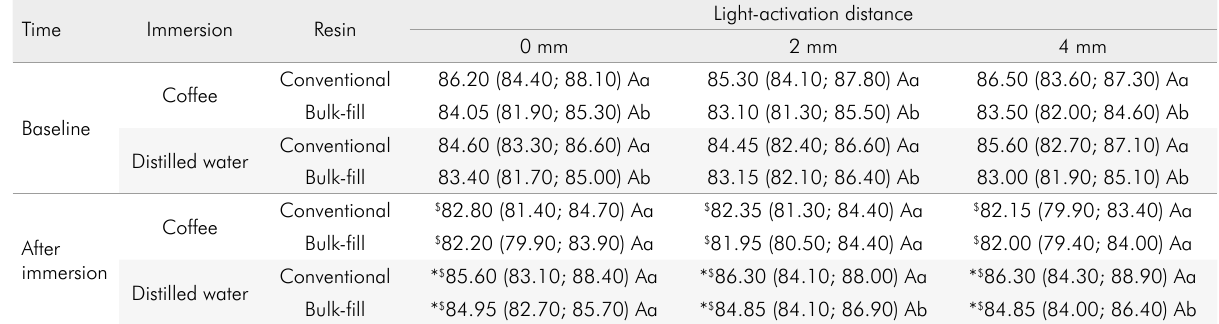
Table 2. Median (minimum value; maximum value) of L* value as a function of composite resin, immersion medium, light-activation distance and evaluation time periods.